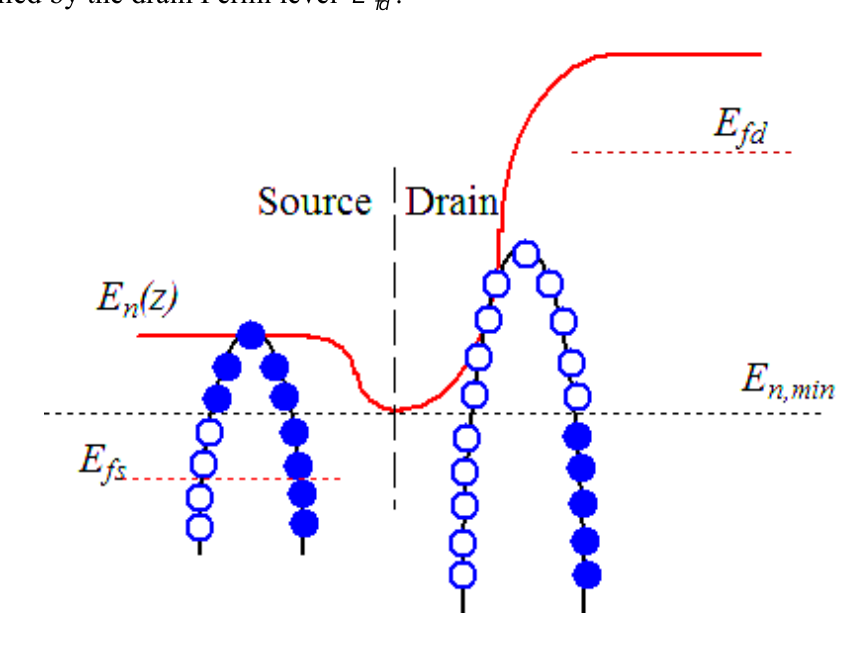
Figure 2. Illustration of the ‘top-of–the-barrier’ ballistic FET model. Semiclassical ballistic transport is assumed for the calculation of hole density and current. Filled circles represent states that are filled by the source Fermi level E and empty circles represent fs states filled by the drain Fermi level E fd